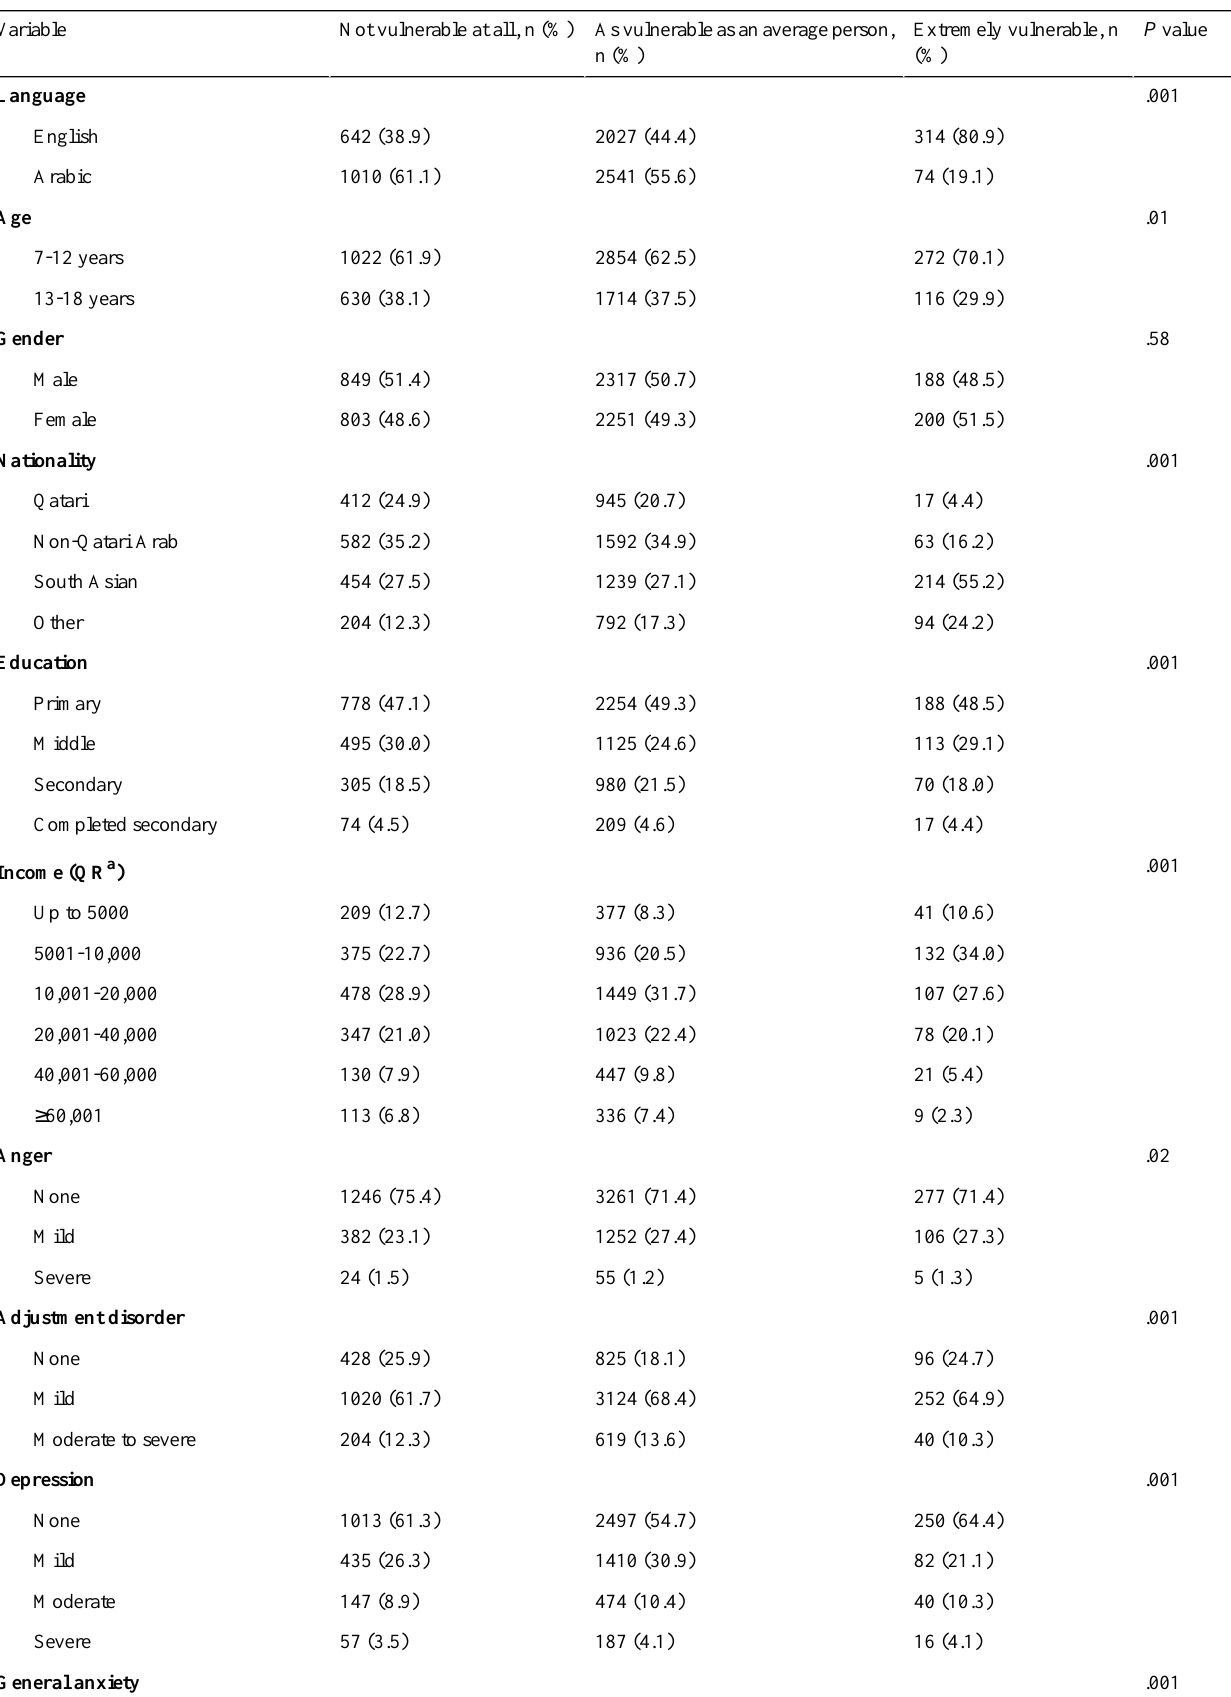
Table 5. Association between the perceived level of vulnerability to corona virus during home isolation and social distancing because of the COVID-19 pandemic with sociodemographic characteristics of participants, final psychological diagnoses and the coping strategies used among children and adolescents in Qatar in 2020